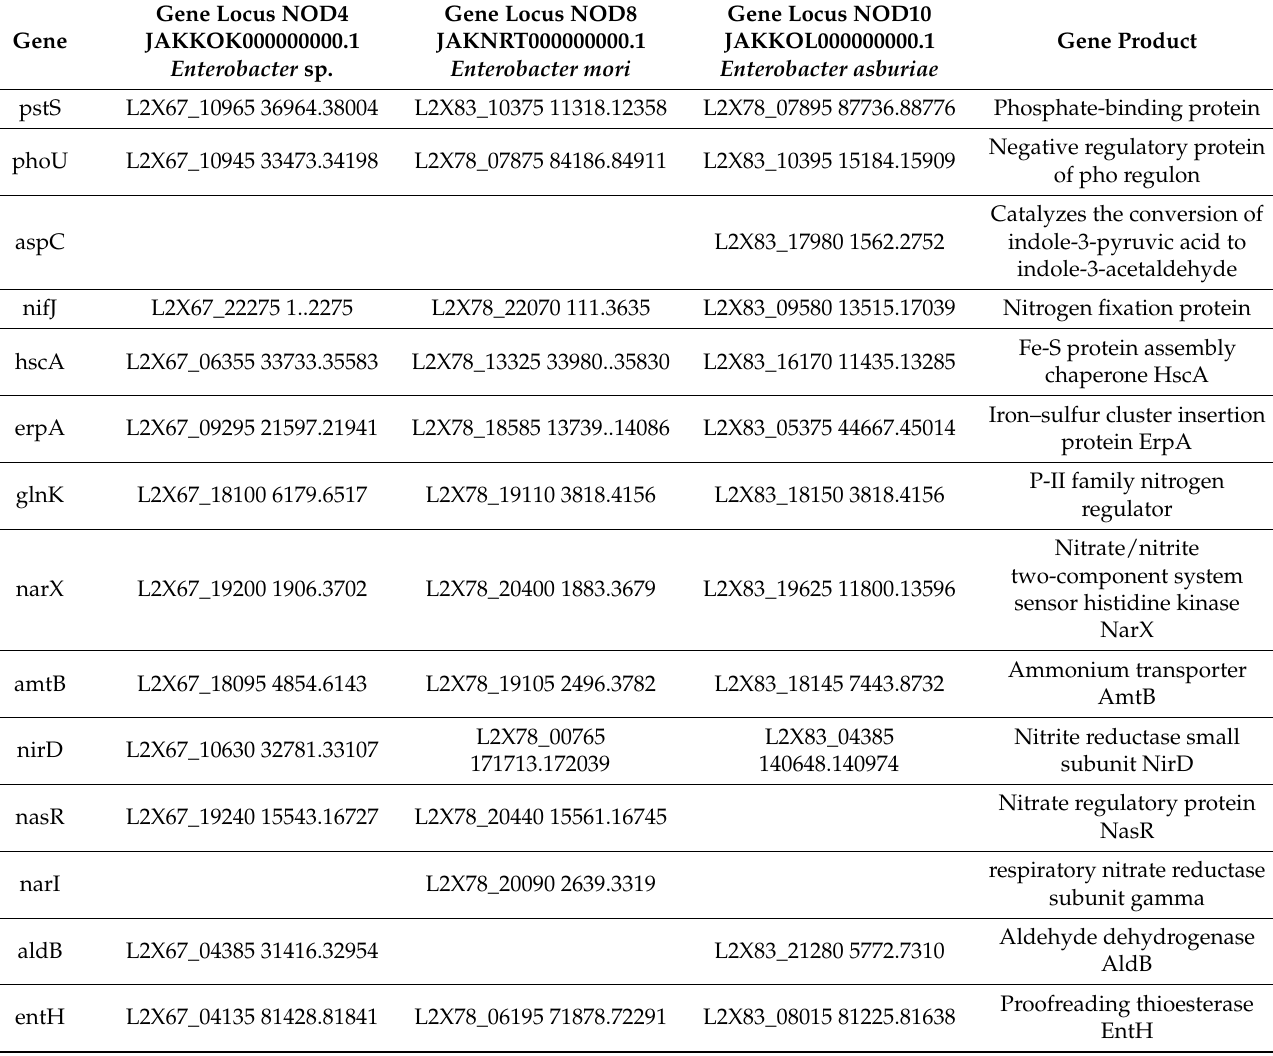
Table 5. Genes involved in possible plant growth-promoting and antagonistic activities in Enterobacter